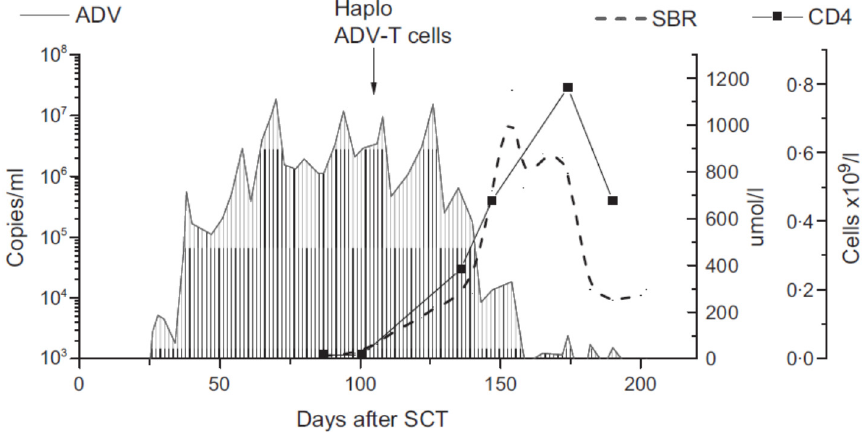
Figure 1. Third-party CTL efficiently cleared viral load in a transplanted child with refractory AdV infection, although significant liver GvHD occurred afterwards. Adapted from Qasim et al. [61].